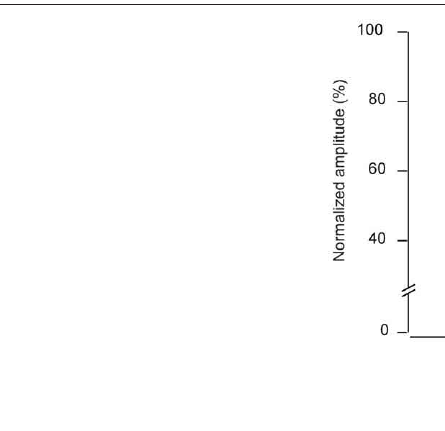
the cell to the three-dimensionally nearest odor-activated glomerulus ( n = 790 cells, 7 experiments). In each experiment the amplitudes of odor-evoked Ca 2 + transients were normalized to the largest recorded value.